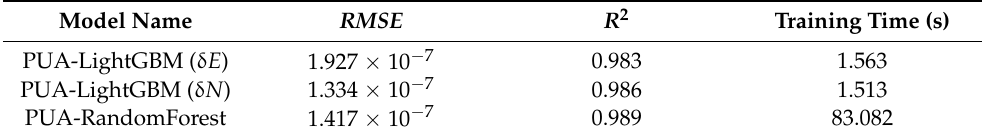
Table 2. Performance comparison of the PUA-LightGBM model to the PUA-RandomForest model. Model Name RMSE R 2 Training Time (s) PUA-LightGBM ( δ E